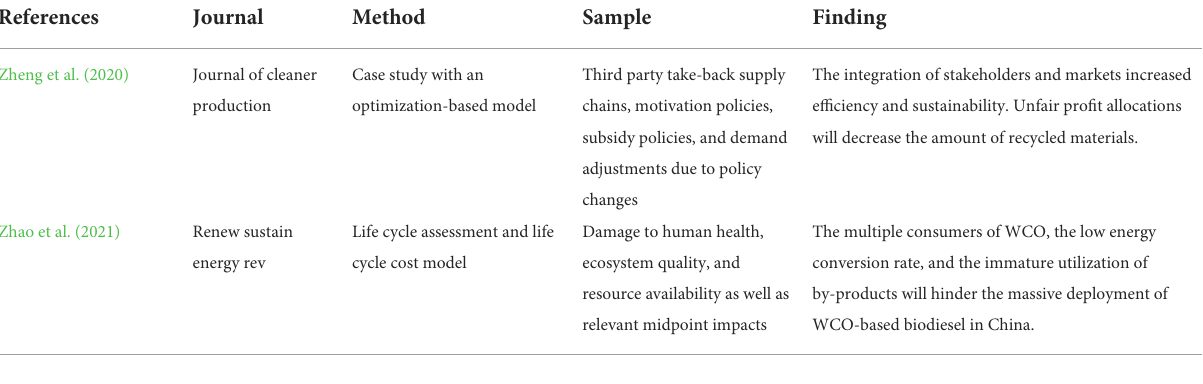
TABLE 4 Types of judgments and distributions of the determinations’ results ( N = 152). Crime